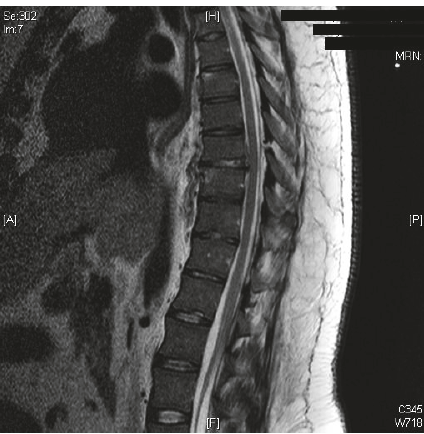
Figure 2: MRI of the thoracic spine at 10 weeks following initial presentation, showing a traumatic spondylolisthesis of T8 on